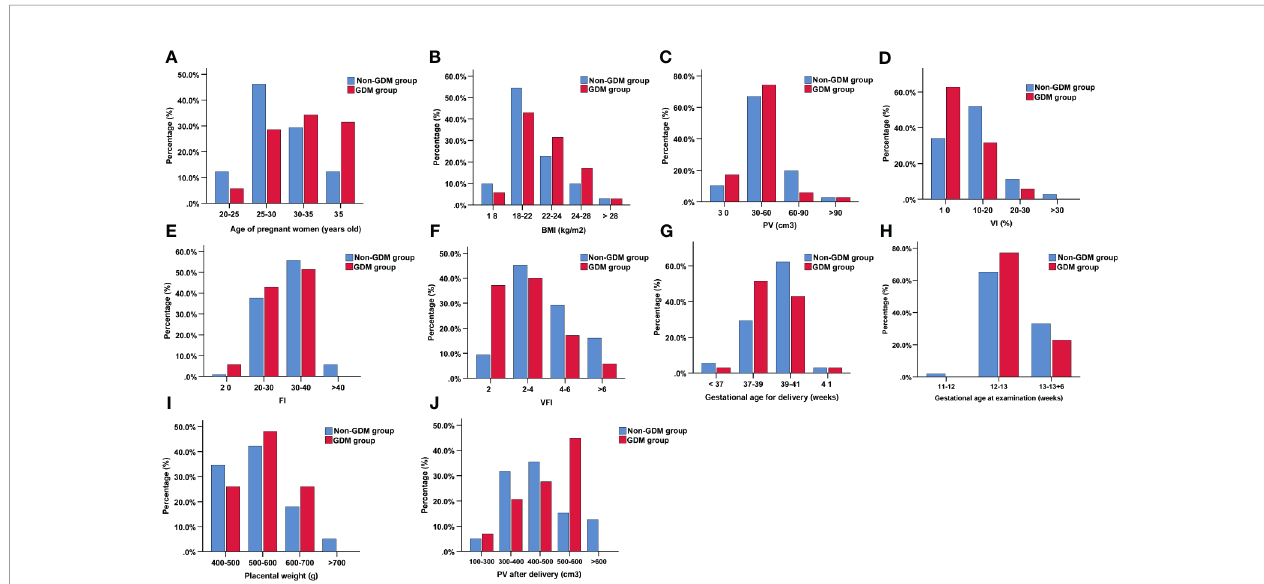
FIGURE 2 | The distribution of pregnant women based on age of pregnant women (A) , BMI (B) , PV (C) , VI (%) (D) , FI (E) , VFI (F) , gestational age for delivery (G) , gestational age at examination (H) , placental weight (I) , and PV after delivery (J)